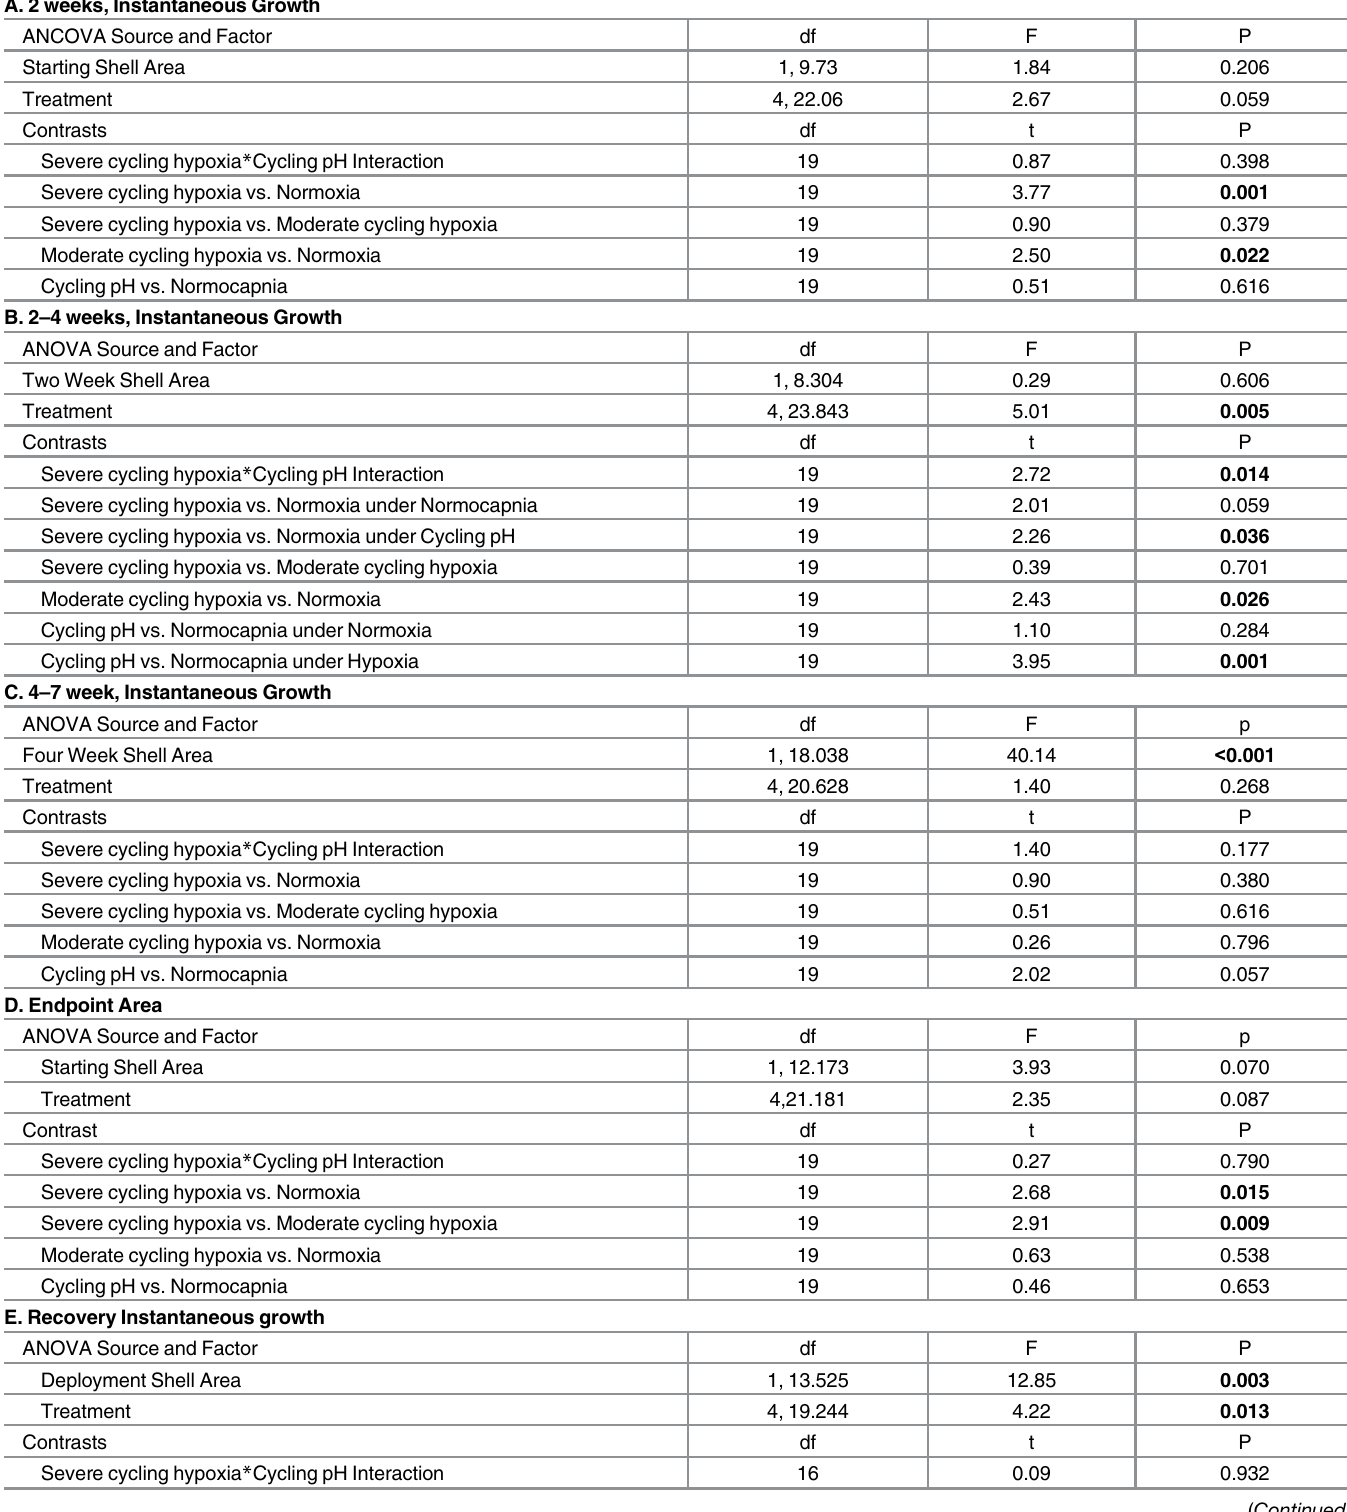
Table 6. 2012 juvenile growth